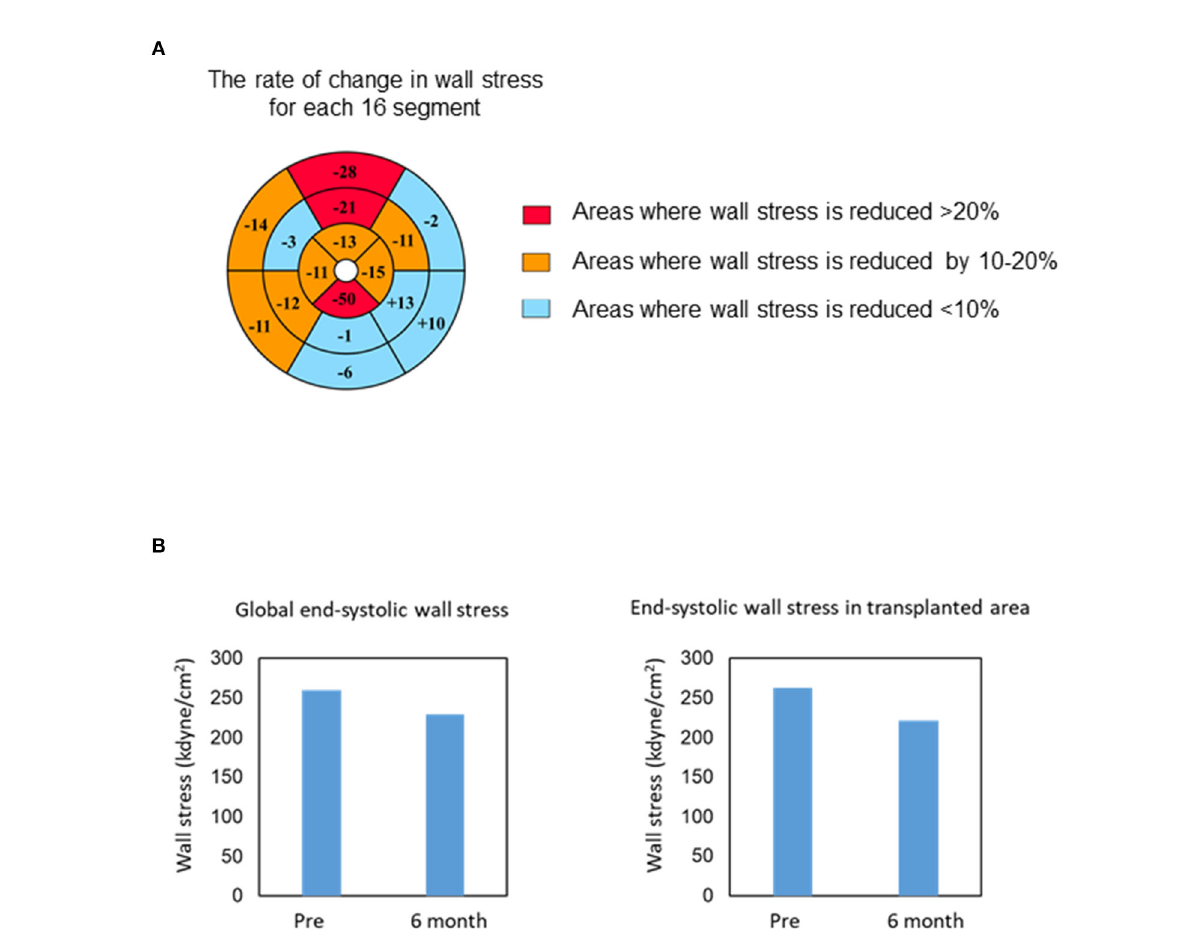
FIGURE3 Changes in end-systolic wall stress. (A) Bull’s-eye grid showing the changes in end-systolic wall stress before and 6 months after surgery, calculated by computed tomography. Red and orange highlight the areas of reduction in wall stress by over 20 and 10–20%, respectively. Light blue highlights the remaining areas. (B) Change in the global (left) and regional (transplanted area, right) end-systolic wall stress 6 months after